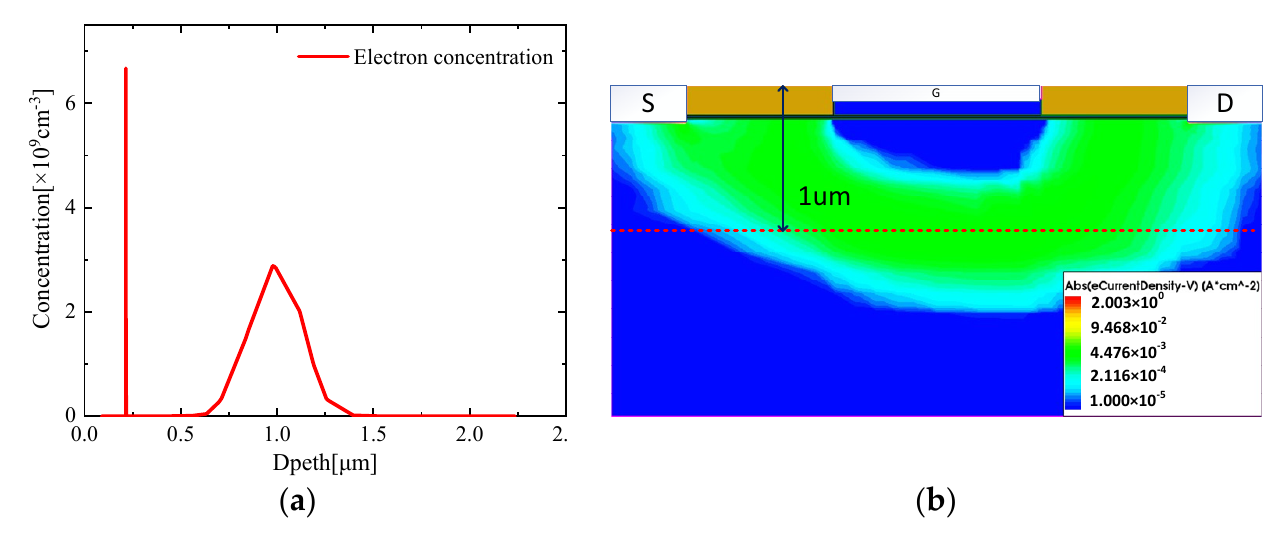
Figure 3. ( a ) Off-state carrier density distribution diagram; ( b ) current density distribution of the device when Vg = 0 V, Vds = 18 V.